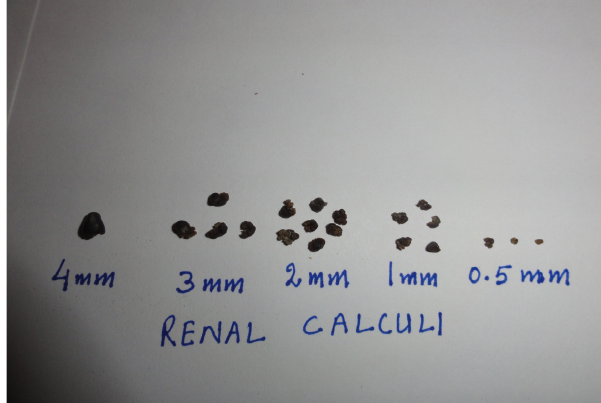
Fig. 2. Different size of renal calculi passed out along with urine after the herbal